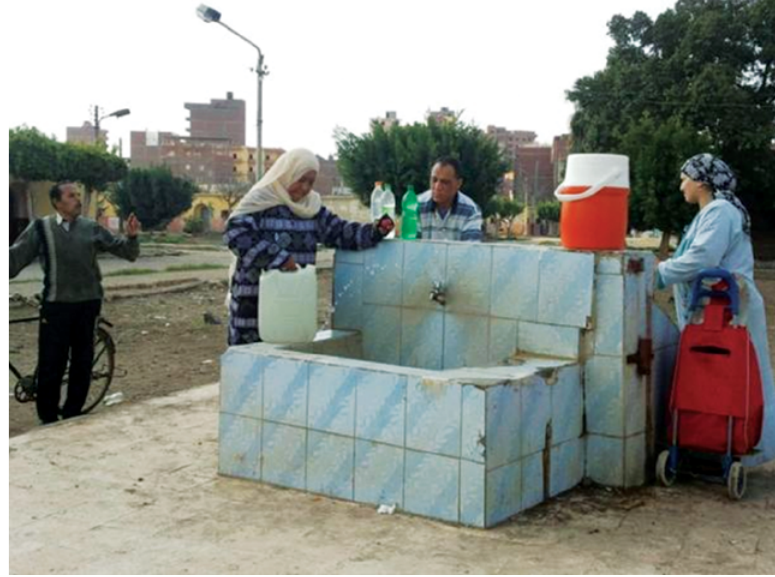
Figure 5. Mosta’amara residents using a communal tap. Yahia